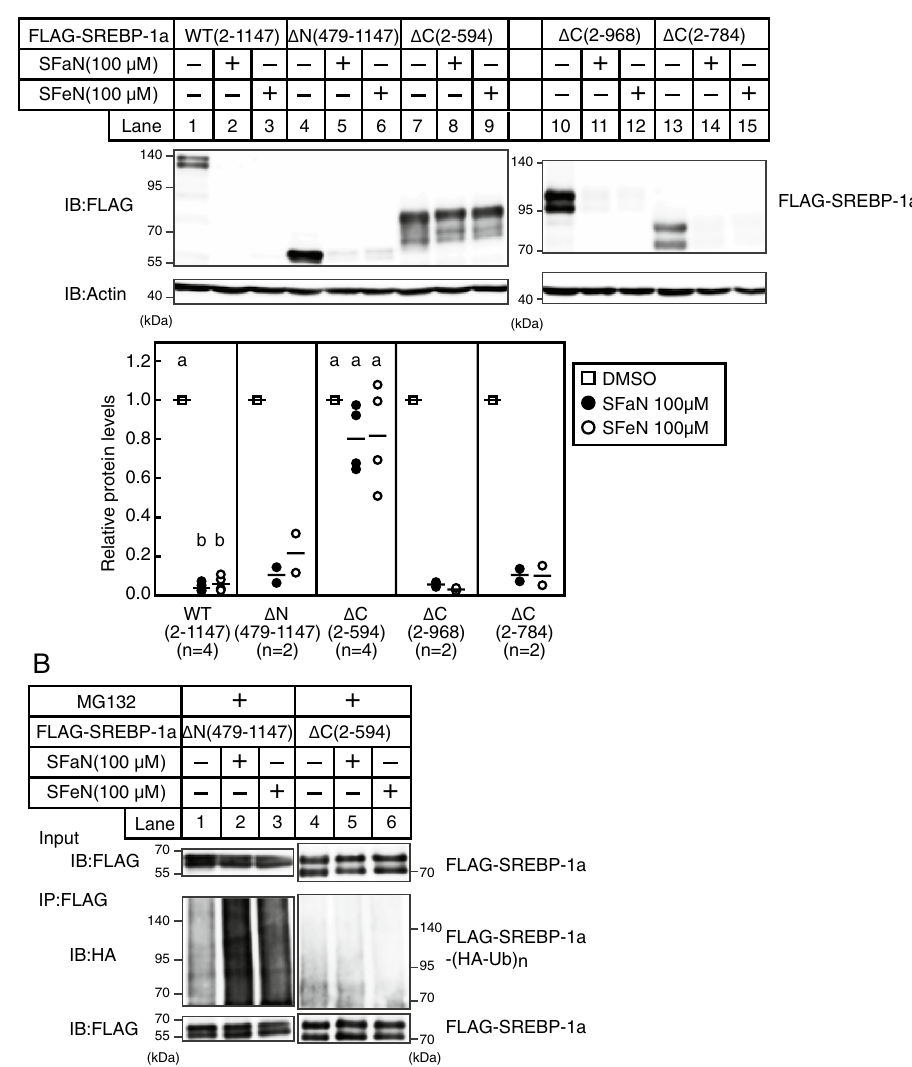
Figure 9. The C-terminal SREBP-1a region is essential for SFaN-mediated SREBP-1a degradation and ubiquitination. ( A ) Huh-7 cells were transfected with pCMV-SREBP-1a-(2–1147)-3 × FLAG, pCMV- SREBP-1a-(479–1147)-3 × FLAG, pCMV-SREBP-1a-(2–594)-3 × FLAG, pCMV-SREBP-1a-(2–968)-3 × FLAG, or pCMV-SREBP-1a-(2–784)-3 × FLAG and cultured in medium B for 24 h. The cells were trypsinized, seeded in six-well plates, and cultured in medium B for 24 h. The cells were then shifted into medium B in the presence of the vehicle, 100 μM SFaN or SFeN. After incubation for 3 h, whole-cell extracts underwent immunoblotting (IB) with anti-FLAG or anti-β-actin antibodies. The signals were quantified by Image J and normalized by β-actin signals, and the signals of the control group treated with DMSO were represented as one (n = 2–4). Different superscript letters denote statistical significance (p < 0.05). Full-length images of all replicates are presented in Supplementary Fig. S8. ( B ) Huh-7 cells were transfected with pCMV-SREBP-1a-(479–1147)-3 × FLAG or pCMV-SREBP-1a-(2–594)-3 × FLAG and HA-Ub and cultured in medium B for 24 h. The cells were trypsinized, seeded in 100 mm dishs, and cultured in medium B for 24 h. After incubation with 10 μM MG132 for 30 min, the cells were shifted into medium B supplemented with 10 μM MG132 in the presence of the vehicle, 100 μM SFaN, or SFeN. After incubation for 3 h, cell lysates were subjected to immunoprecipitation (IP) using an anti- FLAG antibody. The immunoprecipitates were subjected to immunoblotting (IB) with anti-HA or anti-FLAG antibodies. Full-length images are presented in Supplementary Fig.